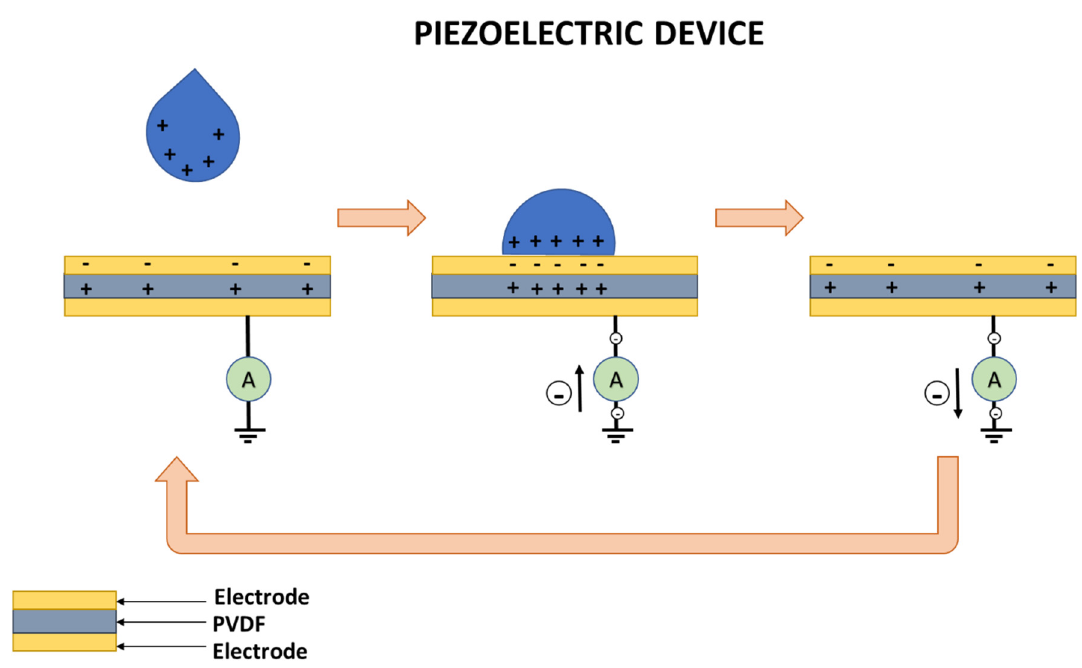
Figure 2. Piezoelectric transducer for the mechanic to electric energy conversion of rain.